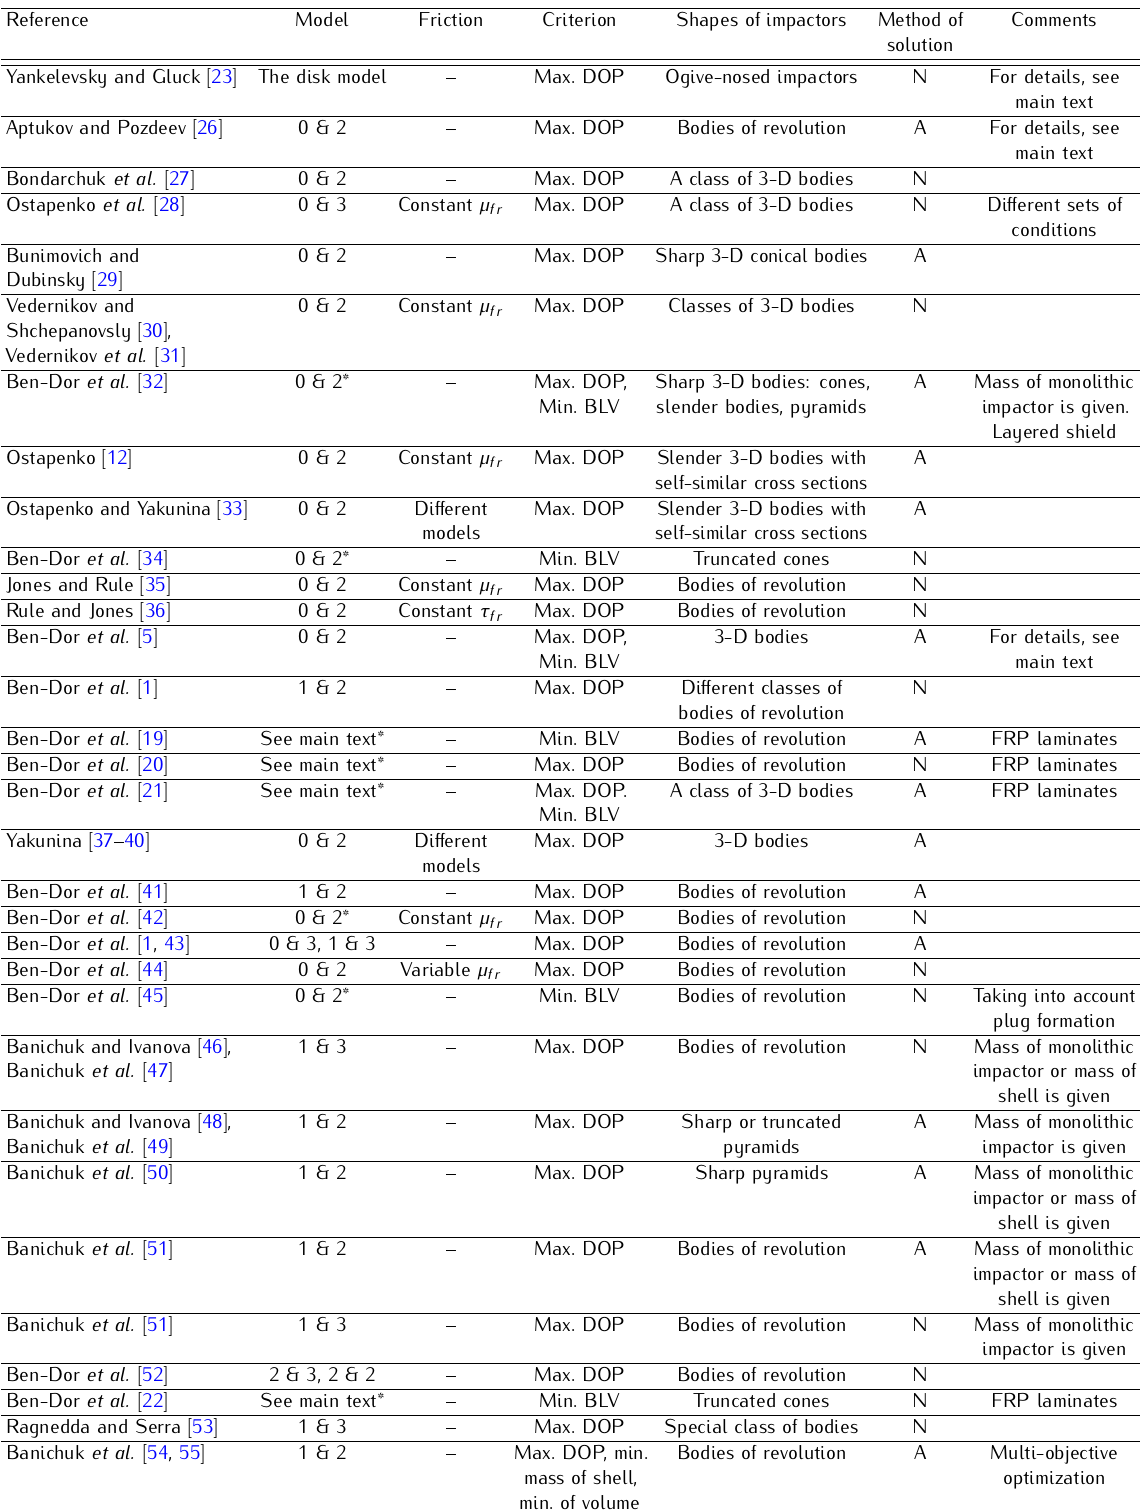
Table 1. Optimization using criteria of maximum DOP and minimum